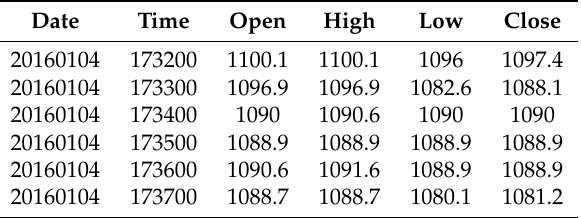
Table 1. Form of training